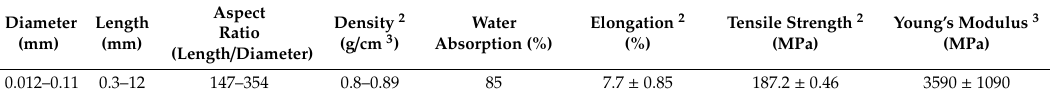
Table 1. Main morphological, physical, and mechanical characteristics of biopolymer fibers (BPFs) 1 . Diameter Length (mm)